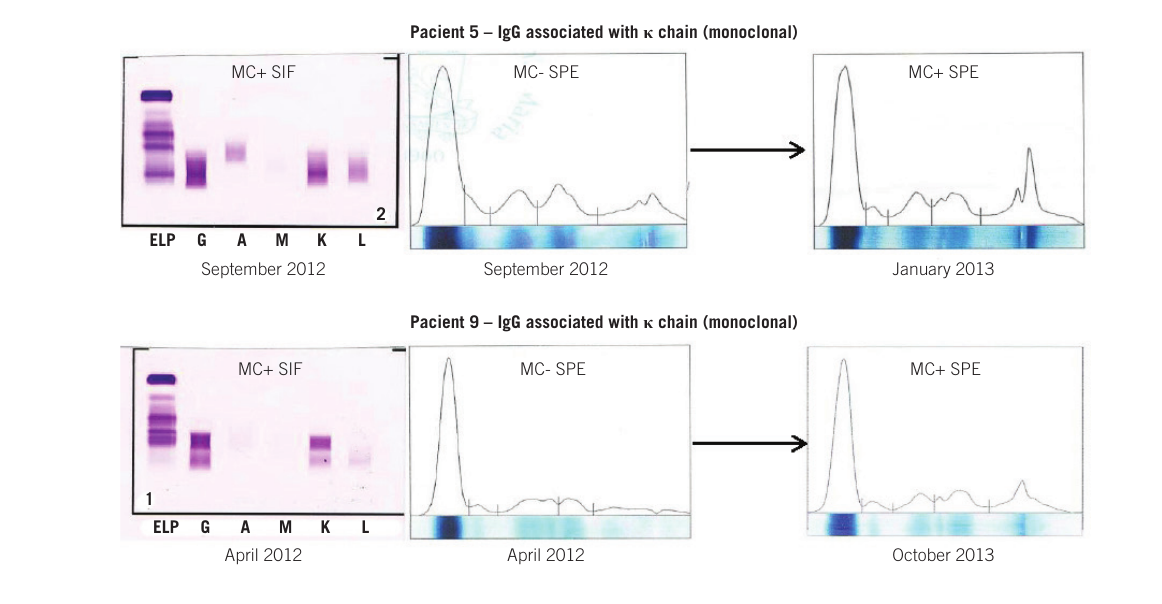
figuRE 3 − Comparative images between SIF and SPE in serum proteins analysis to detect MC in patients 5 and 9, with the same IgG component, at different moments MC+ e MC- indicate the presence and absence of mono/biclonal components, respectively.